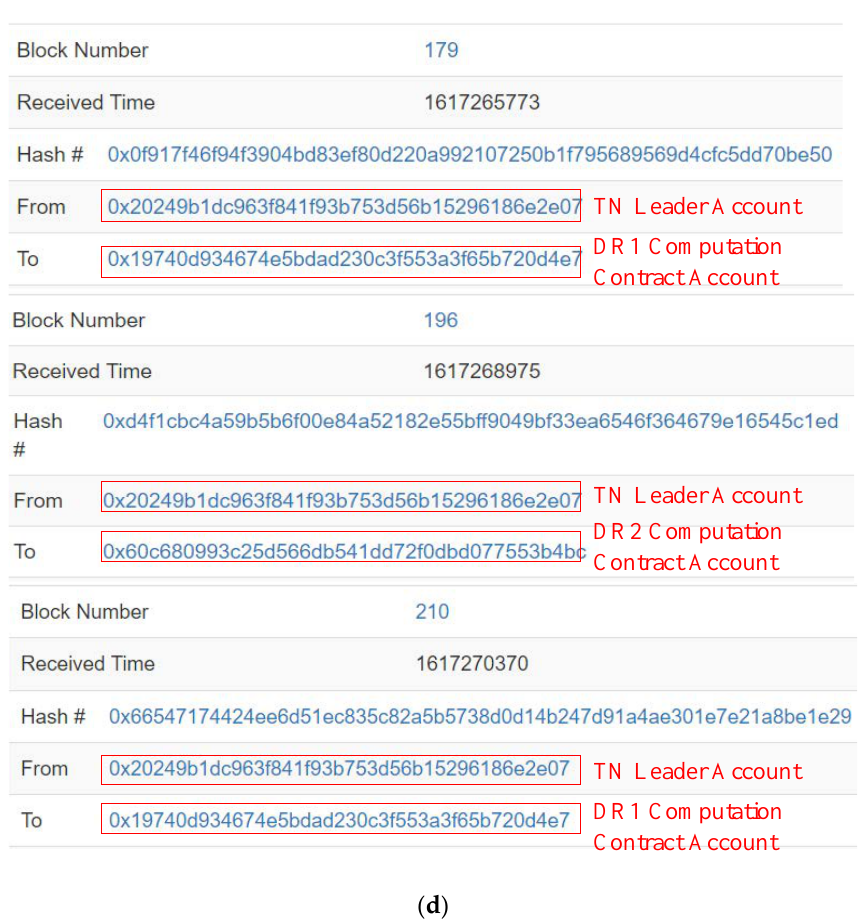
Figure 10. The transaction process of DRs, DPs and TNs. ( a ) DR1 and DR2 publish computation contract. ( b ) TN leader prioritizes appropriate DP with selection rule. ( c ) DPs send data to TN leader at different times. ( d ) TN leader perform computation for DR1 and DR2.